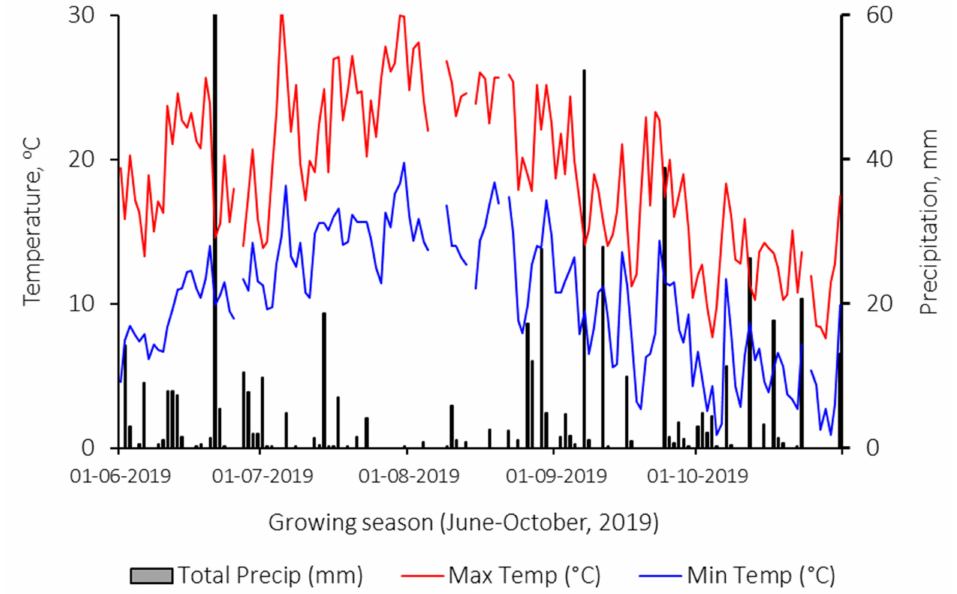
Figure 1. Ambient air temperature (minimum and maximum) and precipitation trends during the trial season (i.e., June–October